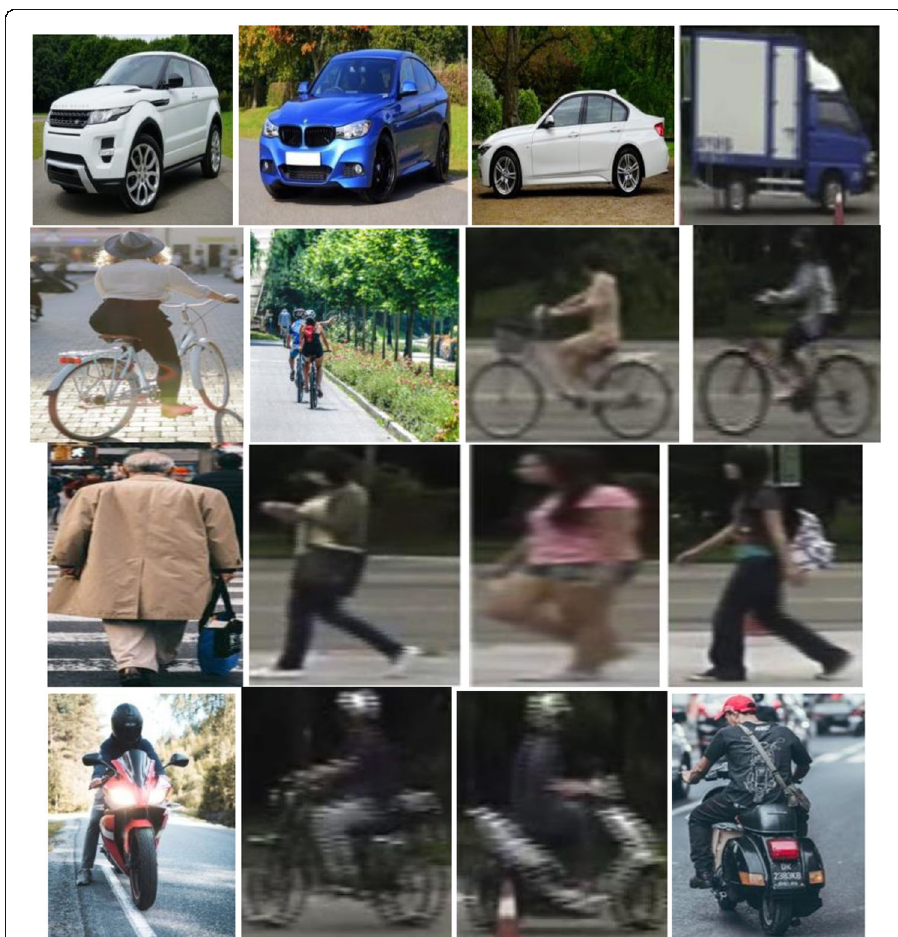
Fig. 2 Training samples collected for each class in different